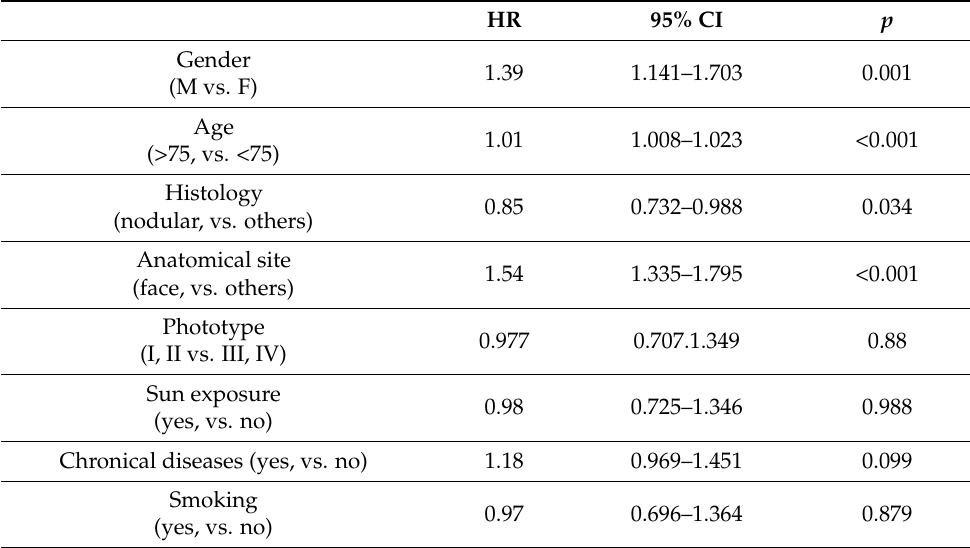
Table 6. Multivariate analysis of risk factors for the development of multiple